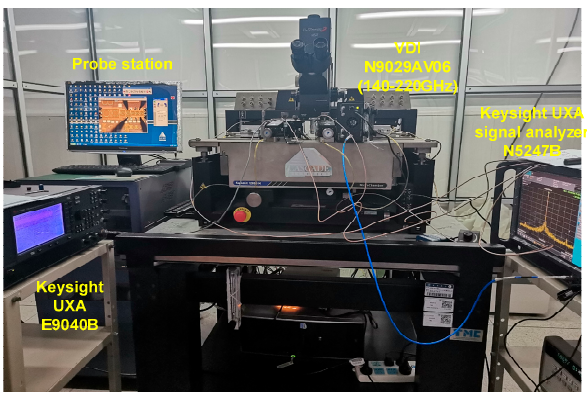
Figure 13. The measurement setup.